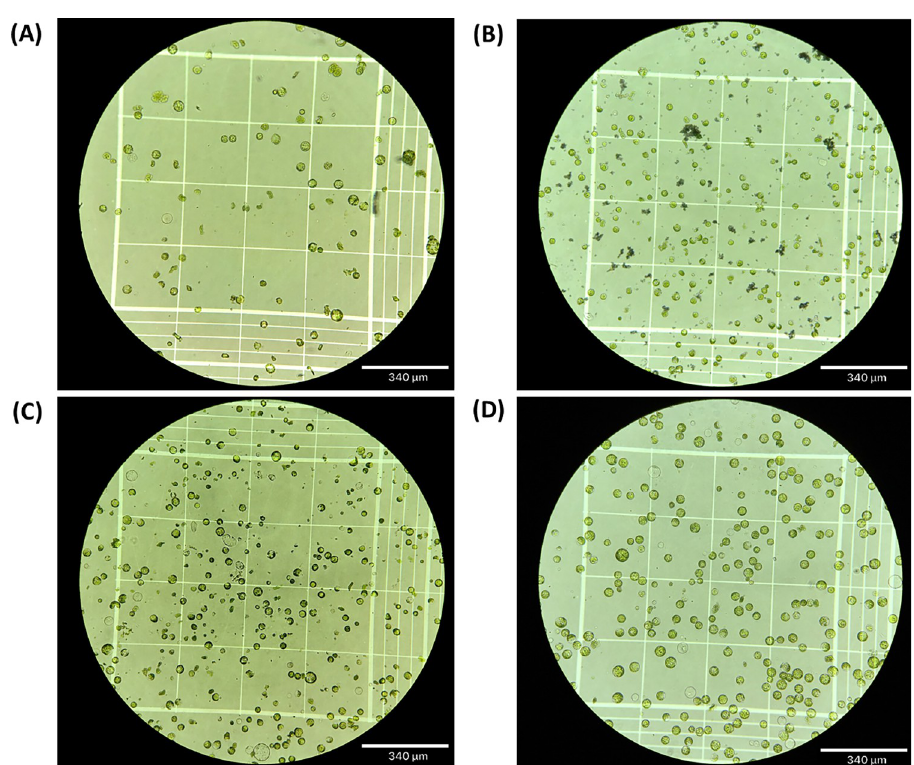
Fig 1. Comparison of protoplast isolation from leaf cutting method versus tape sandwich methods. (A) Protoplasts isolated via the original leaf-cutting method. (B) Protoplasts isolated via the tape sandwich method from 7-day-old plants without optimization. (C) Protoplasts isolated via the tape-sandwich method from 7-day-old plants with optimization. (D) Protoplasts isolated via the tape-sandwich method from 12-day-old plants with optimization.